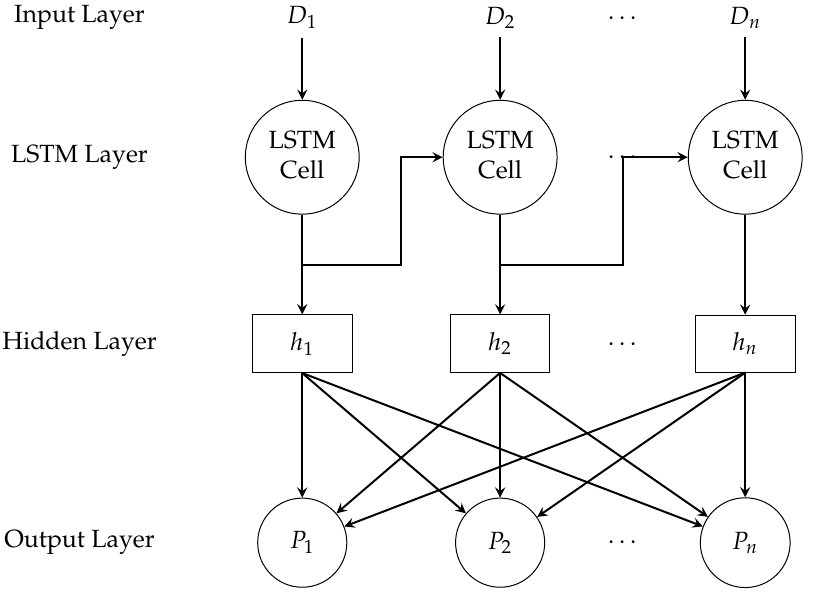
Figure 7. Long short-term memory (LSTM)